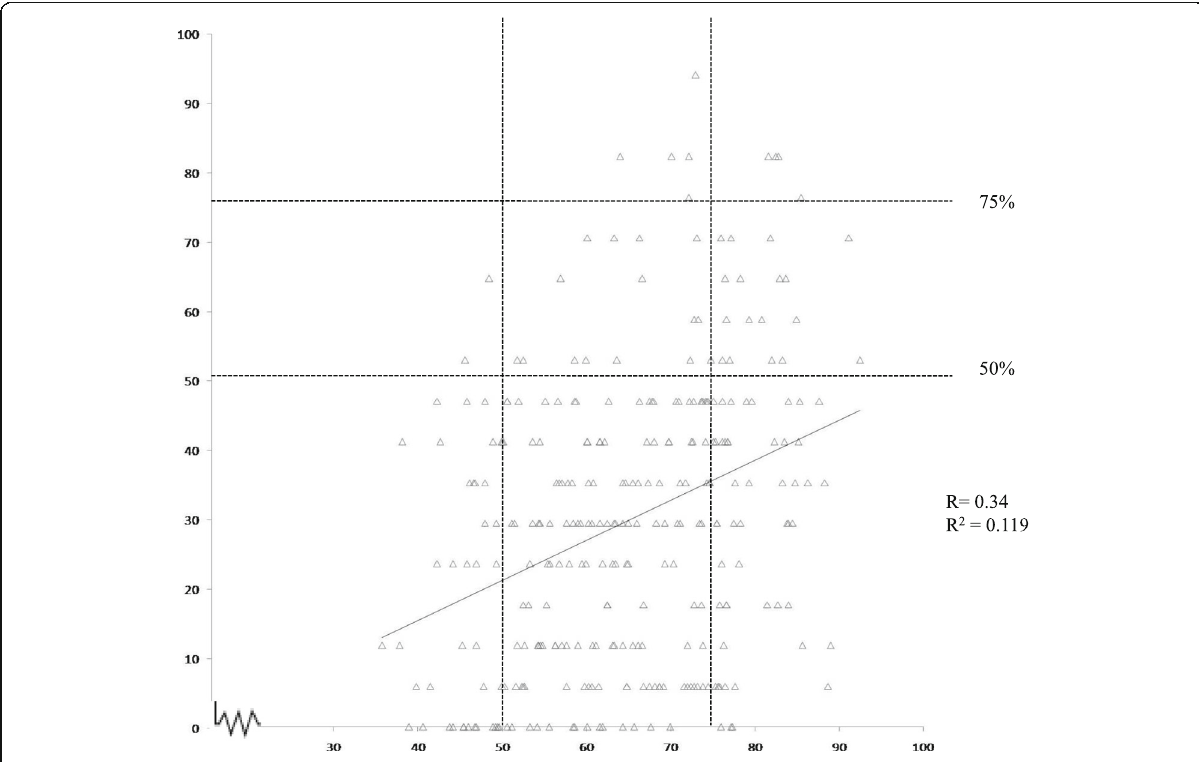
Fig. 2 Correlation between scores obtained in university exams and three questions on growth and control of microorganisms from our questionnaire. The x -axis represents the percentage of marks obtained by students of group 2 in their first year of the degree course (MB/BT). The y -axis represents the percentage of marks obtained by students in three questions on the growth and control of microorganisms from our